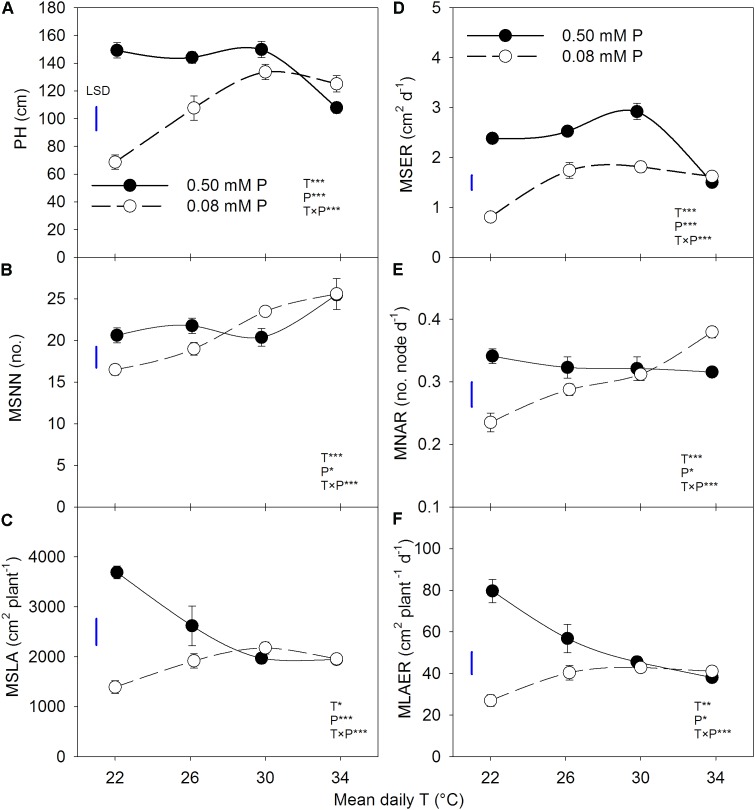
Temperature (T) response of (A) plant height (PH) and (B) mainstem node number (MSNN) at 118 DAP and (C) leaf area (MSLA) at 63 DAP, (D) mainstem elongation rate (MSER), (E) mainstem node addition rate (MNAR), and mainstem (F) leaf area expansion rate (MLAER) of soybean grown at four temperatures under phosphorus (P) sufficient (0.50 mM P, filled symbols) and P-deficient (0.08 mM P, unfilled symbols) conditions. Symbols represent the mean ± se of seven plants. Smooth lines through the data points are presented. The analysis of variance for the effect of treatments and their interaction (T, P, T × P) is also shown by the significance levels where ∗, ∗∗, and ∗∗∗ represent P ≤ 0.05, P ≤ 0.01, and P ≤ 0.001, respectively. The magnitude of the least significant difference (LSD) is shown by the length of the vertical line. Error bars smaller than the symbol are not visible.